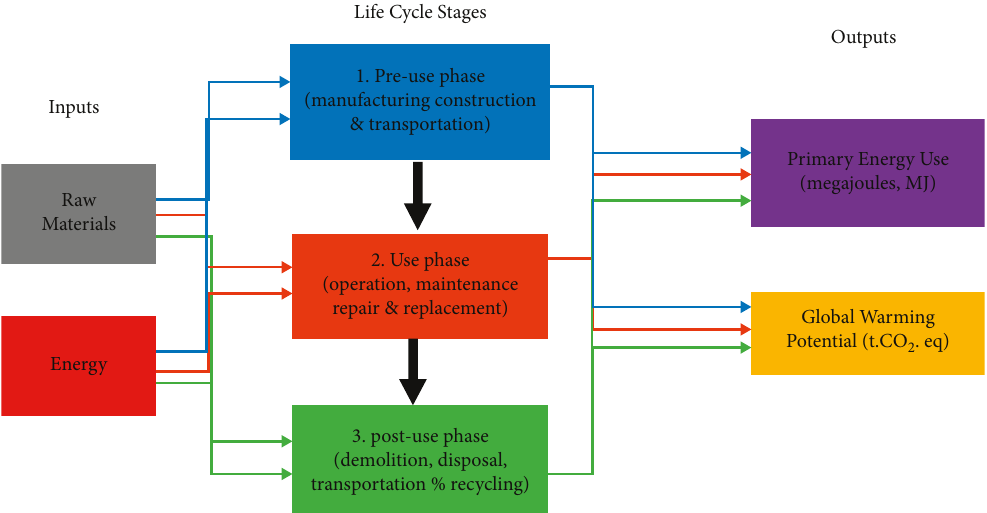
Figure 8: Building life cycle analysis scheme